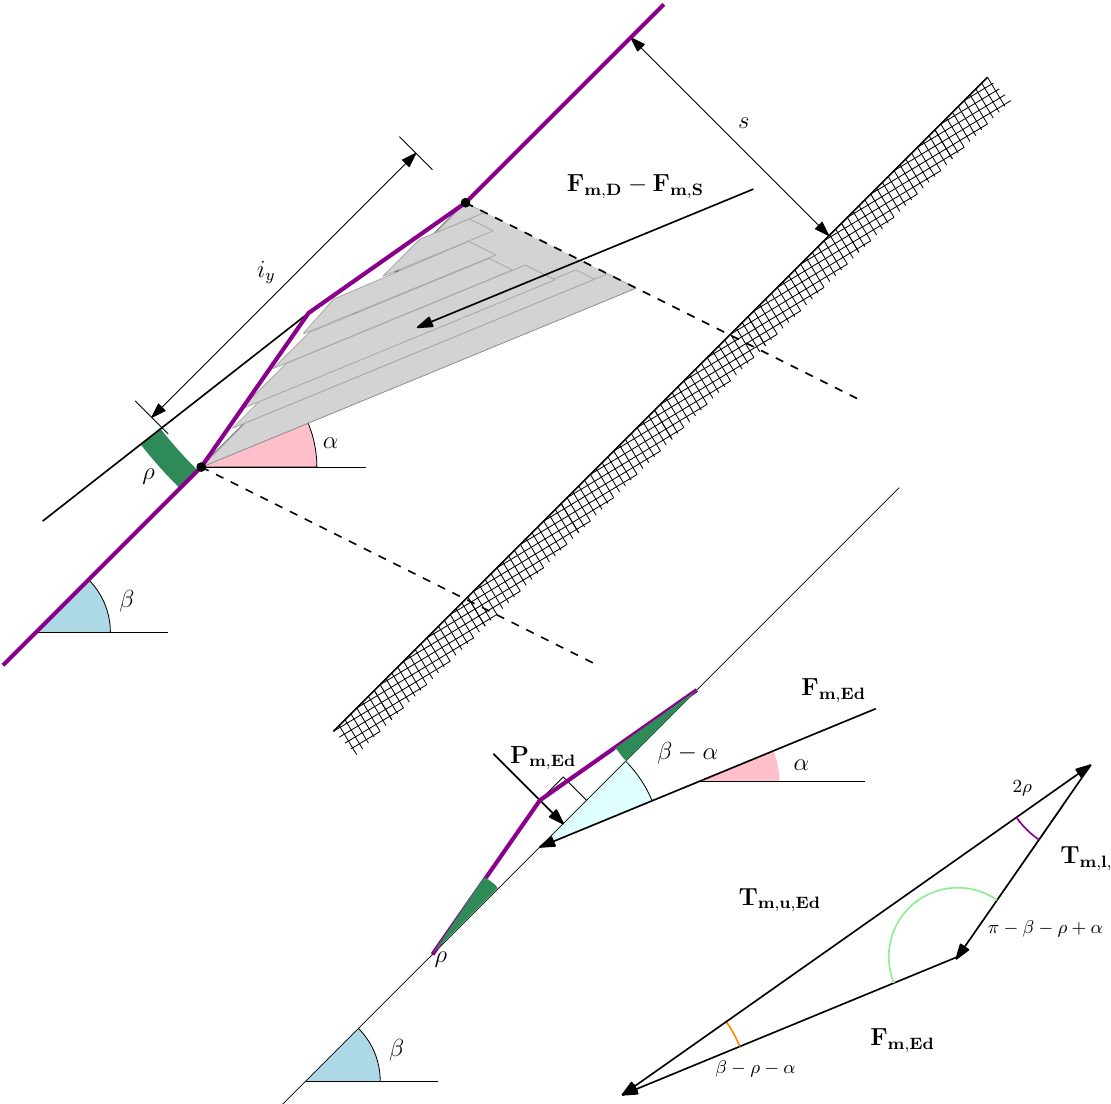
Figure 7. Sketch of the force acting on the mesh considering local instability along a